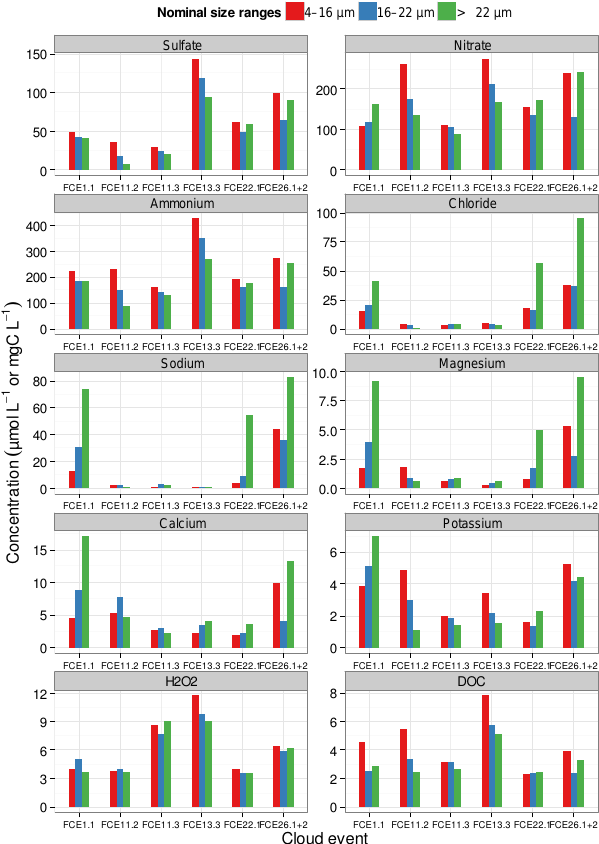
Figure 7. Size-resolved cloud water concentrations from five- stage collector. Volume-weighted mean concentrations per event are given in µmolL − 1 .